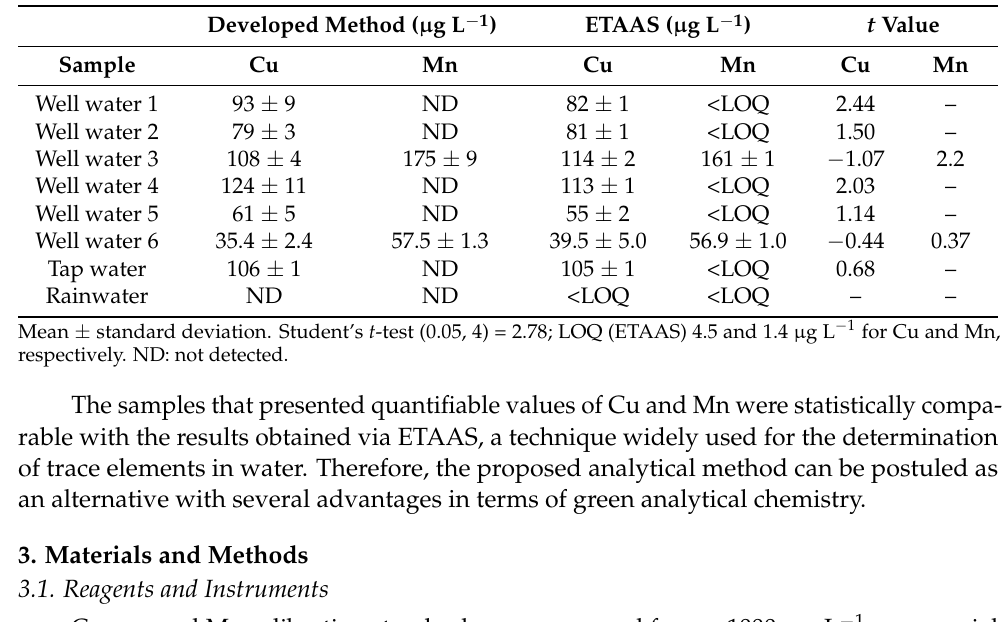
Table 4. Comparison of Cu and Mn levels in sample waters using